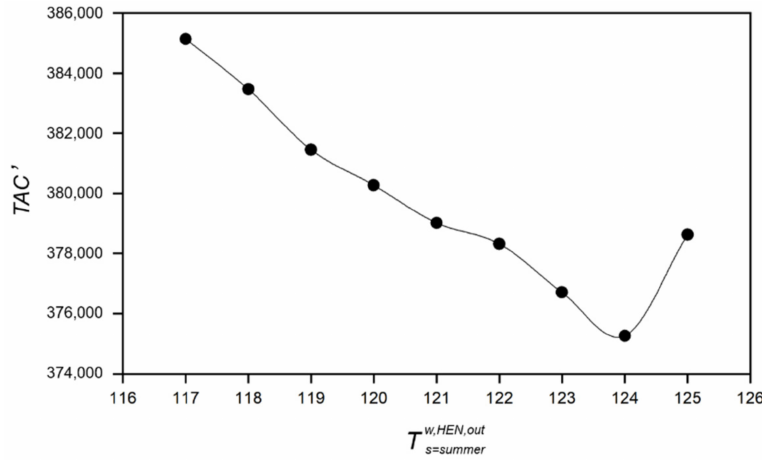
Figure 8. Sensitivity analysis of T w , HEN , out s = summer